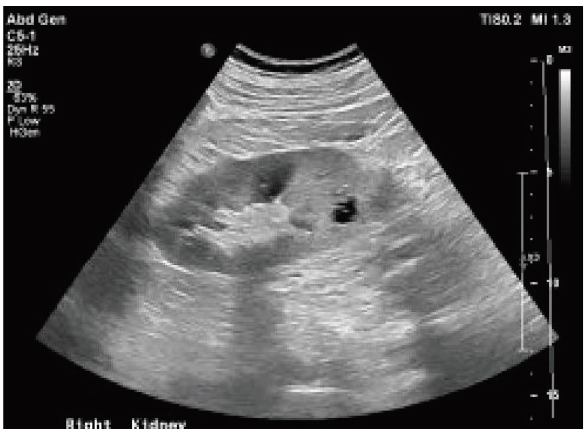
Figure 5: Renal US right kidney.